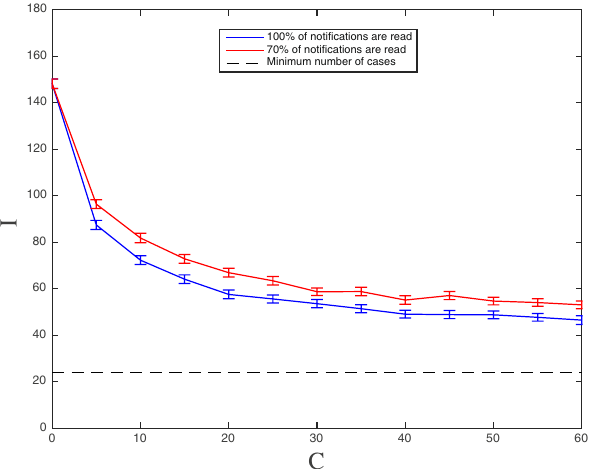
Figure 14. The mean number of infected individuals at equilibrium (and 95% confidence intervals) as a function of the number of selected nodes based on eigenvector centrality (EC) with 100% response (blue line) and 70% response (red